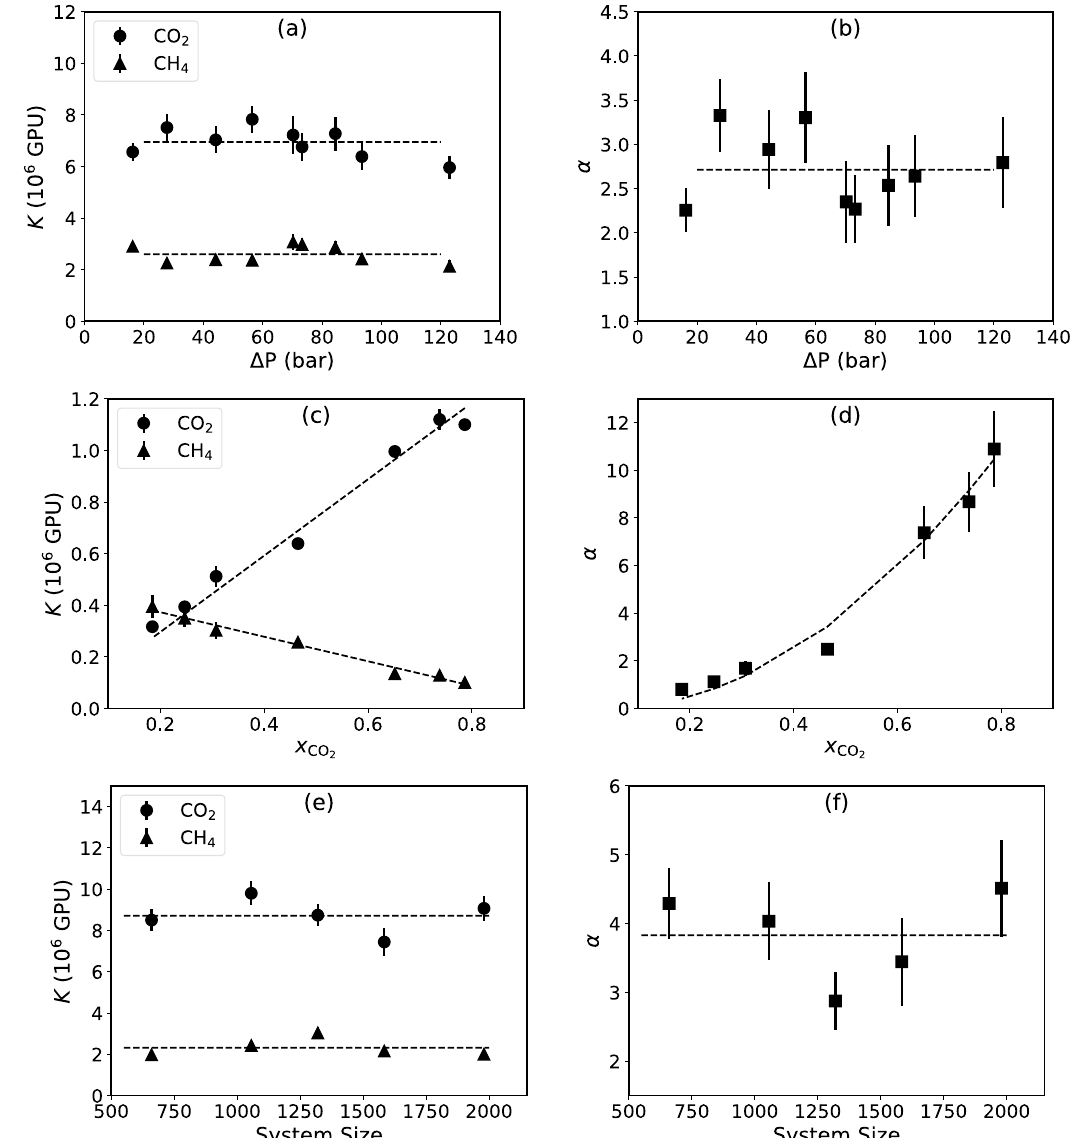
Figure 4. The effect of pressure ( a , b ), concentration ( c , d ) and system size ( e , f ) on the permeance and selectivity in the separation of CH 4 /CO 2 mixture. The pressure and concentration results are for equimolar mixture with a total of 660 molecules, and the system size graphs are the results for equimolar mixtures with a 660 to about 2000 total molecules. ( a , b ) The permeance is independent to the pressure difference. ( c , d ) Increasing the concentration of CO 2 results in a linear increase and decrease in the permeance of CO 2 and CH 4 , respectively. ( e , f ) Increasing the system size shows no change in the permeance and selectivity, hence showing the scalibility of the is considered as the interaction energy, which tends to zero as the separation increases, as shown for all the investigated molecules and orientations in Fig. 6. It can be seen that the potential energy profile for hydrogen is completely different from those of the other three gases, lacking any trapping minimum, hence making it more probable than the other three gases to pass through the graphye-3 membrane. It also indicates the existence of a possible high barrier against C 2 H 6 near the surface, hence explaining the two orders of magnitude difference between its permeance and that of H 2 , and the smaller permeance by one order of magnitude than those of CO 2 and CH 4 . Comparing CO 2 and CH 4 , one can see that there exists a direction ( z ) in which both have straight paths to the membrane without barrier. The difference between this direction and the other two ( x and y ) is, however, much more for CO 2 , making the z -orientation more preferable for CO 2 , and giving rise to a larger permeance than CH 4 . Therefore, the poten- tial energy calculations also indicate the same permeance behaviour, ( H 2 > CO 2 > CH 4 > C 2 H 6 ), as the MD